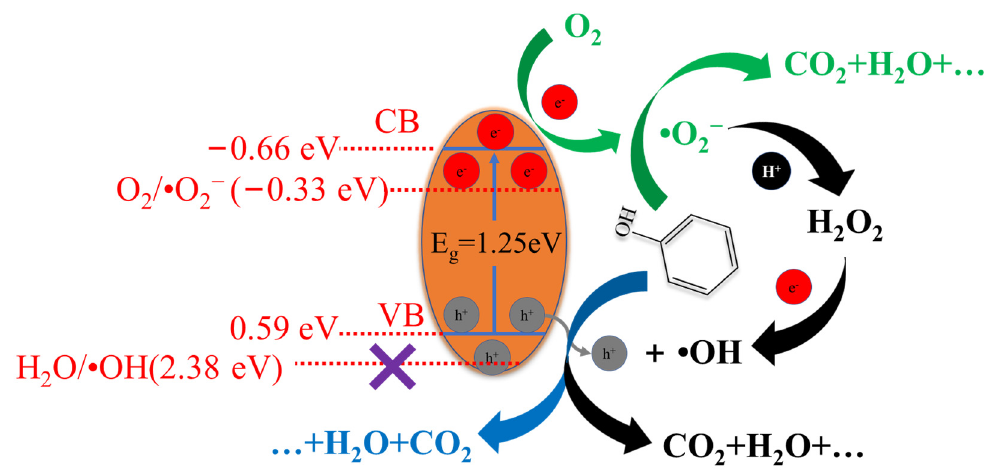
Scheme 1. Schematic illustration of the non-stacked γ -Fe 2 O 3 /C@TiO 2 .